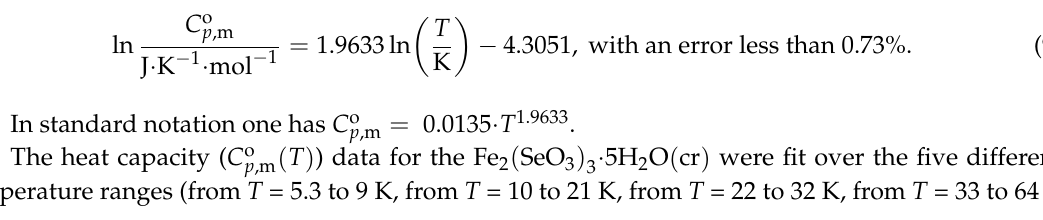
Figure 4. Temperature dependence of isobaric heat capacity, C o p , m ( T ) /J · K − 1 · mol − 1 , of mandarinoite (cr) in the temperature range from T = 5.2 K to 324.8 K. Experimental data obtained using liquid helium ( T = 5.2 K to 85.4 K) are shown as open circles ( ○ ) and experimental data using liquid nitrogen ( T = 78.7 K to 324.8 K) are shown as solid circles (●). The solid curve corresponds to extrapolation of experimental data using Equation (10).